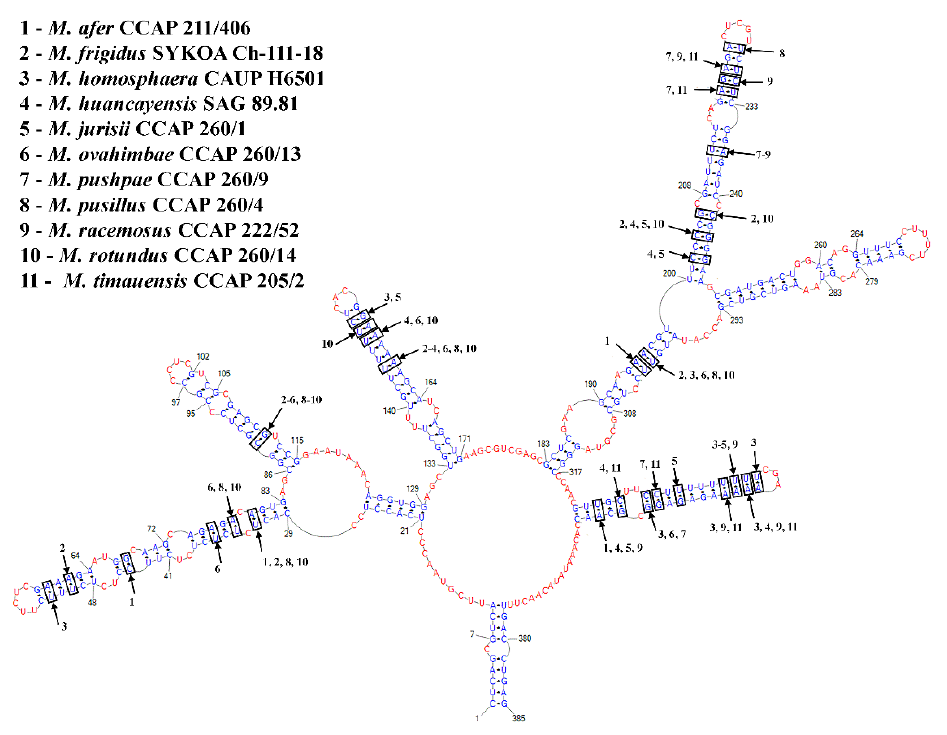
Figure 4. Predicted secondary structure of the nuclear internal transcribed spacer 2 of the strain M323 ( Mychonastes hindakii sp. nov.). Black boxes indicate the positions of Compensatory Base Changes (CBCs) between M. hindakii and other species of the genus. Table 2. Number of CBCs/ hemi-CBCs in ITS2 and based on this marker p-distances between M. hindakii M 323 (367 nt) and other species of the